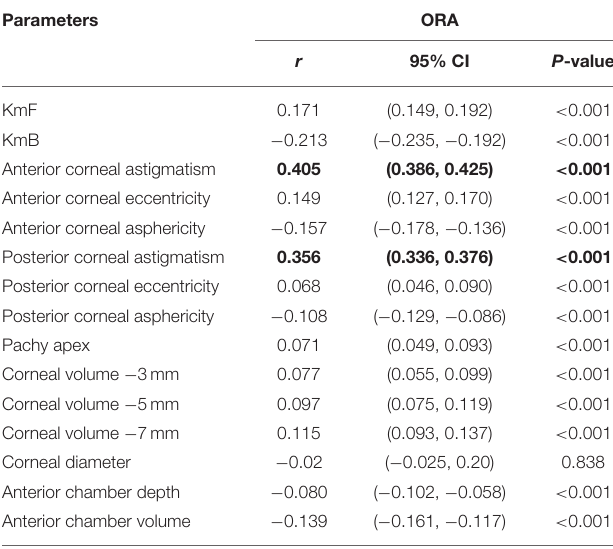
TABLE 2 | Summary of Spearman’s correlation analyses between ORA with other anterior segment parameters.